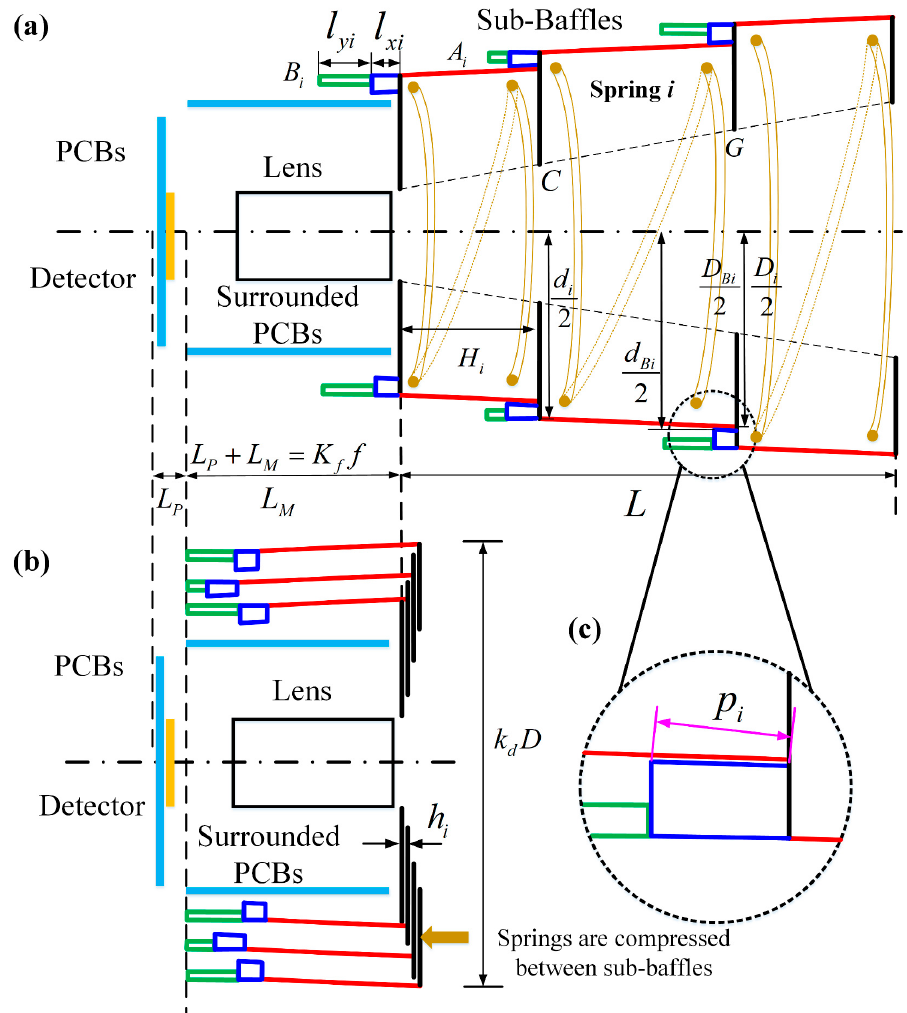
Figure 8. ( a ) Deployed state of deployable star tracker. ( b ) Suppression state of deployable star tracker. ( c ) Detail view for the contact part.